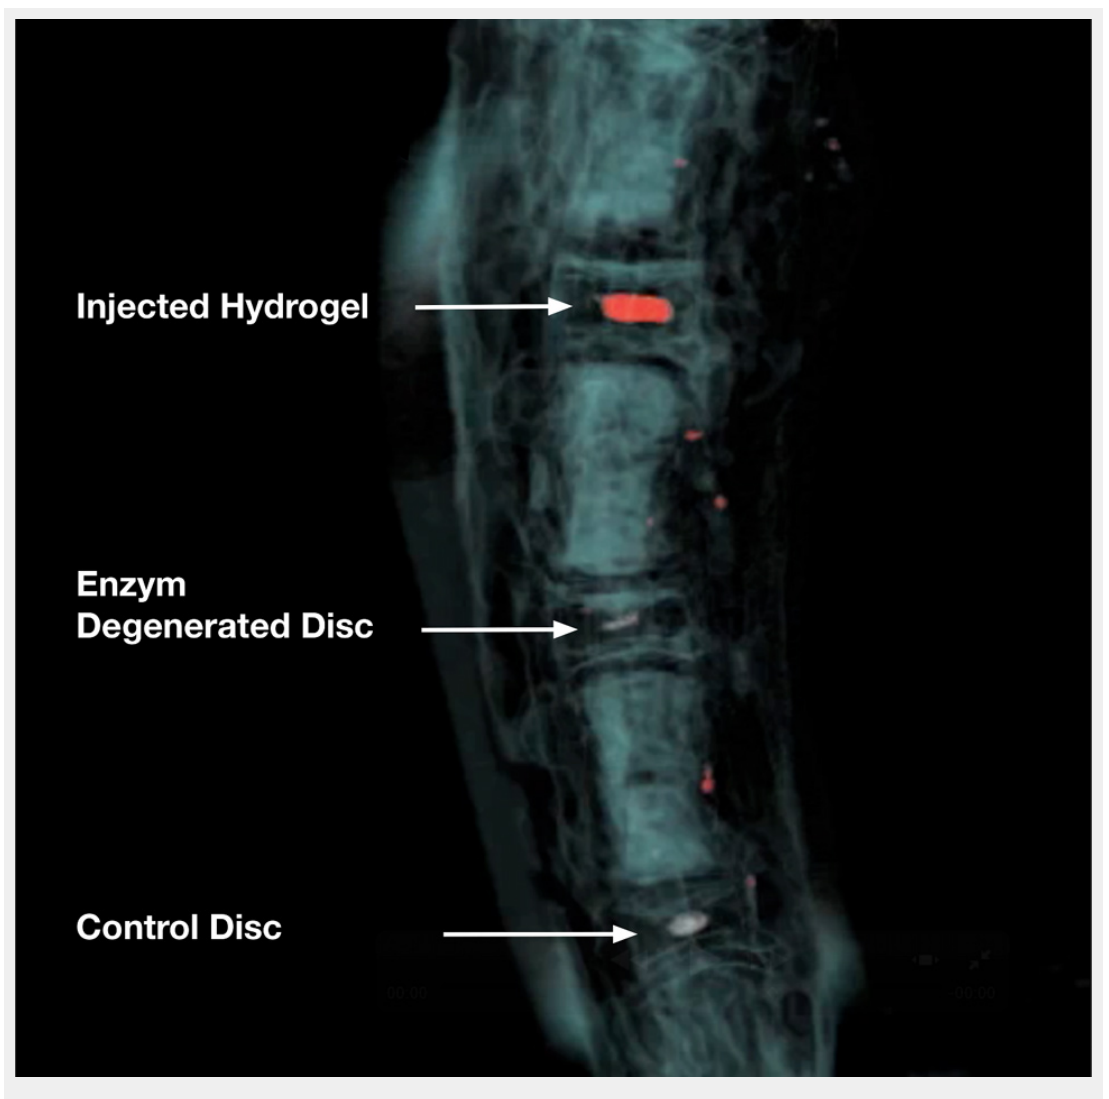
Figure 2 3D reconstruction of Magnetic Resonance Image (MRI) of a bovine tail intervertebral disc animal model. The upper two discs were treated with a certain dose of papain for 7 days to initiate disc degeneration. The papain enzyme was blocked with ebselen after 5 days. The NP region of the uppermost disc was then filled with a thermo-reversible p-NIPAM hydrogel (~200 µL) and imaged after ~24h on a 3 Tesla scanner